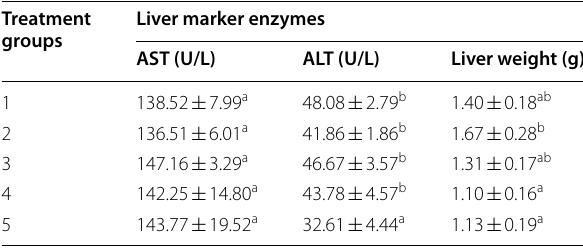
The results are expressed in means letters as superscripts (a, ab, b) down the group (columns) are considered to be significantly different at p < 0.05